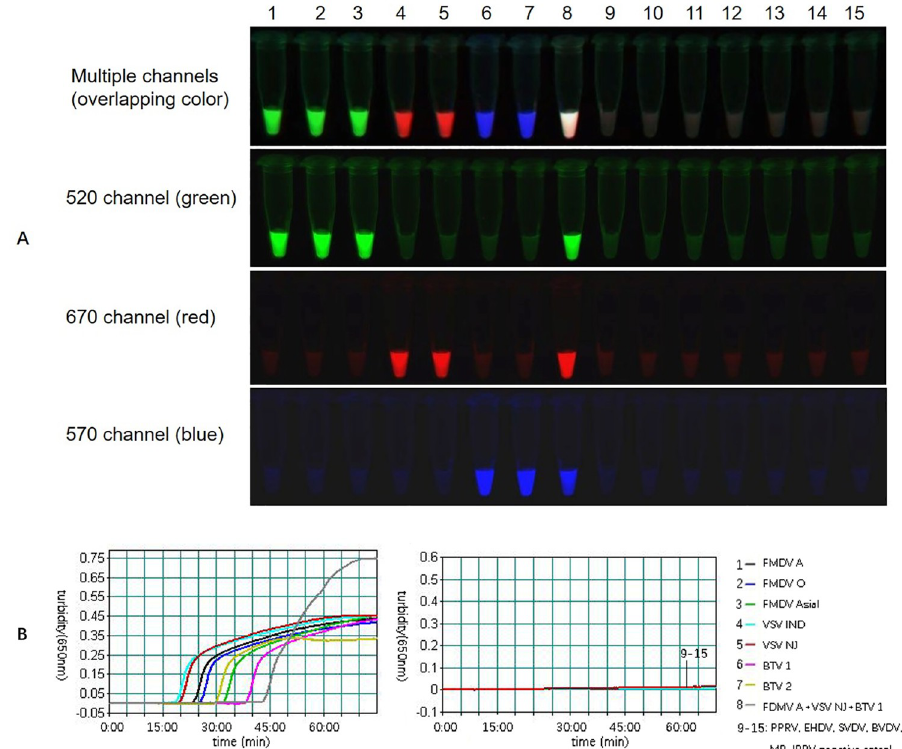
Fig 6. Specificity of mLAMP. The fluorescent mLAMP products were imaged separately using multiple channels (A). The turbidity curve was generated by a real-time turbidimeter to interpret the process of amplification (B). Green fluorescence (FAM) indicates FMDV-positive amplification, red fluorescence (Cy5) indicates VSV-positive amplification, and blue fluorescence (Cy3) indicates BTV-positive amplification. Overlapping fluorescence indicates multiple positive amplifications. Lane 1: FMDV A, lane 2: FMDV O, lane 3: FMDV Asia I, lane 4: VSV IND, lane 5: VSV ND, lane 6: BTV 1, lane 7: BTV 2, lanes 8: FMDV A+ VSV IND + BTV1; 9–15: PPRV, EHDV, SVDV, BVDV, MB, IBRV, negative